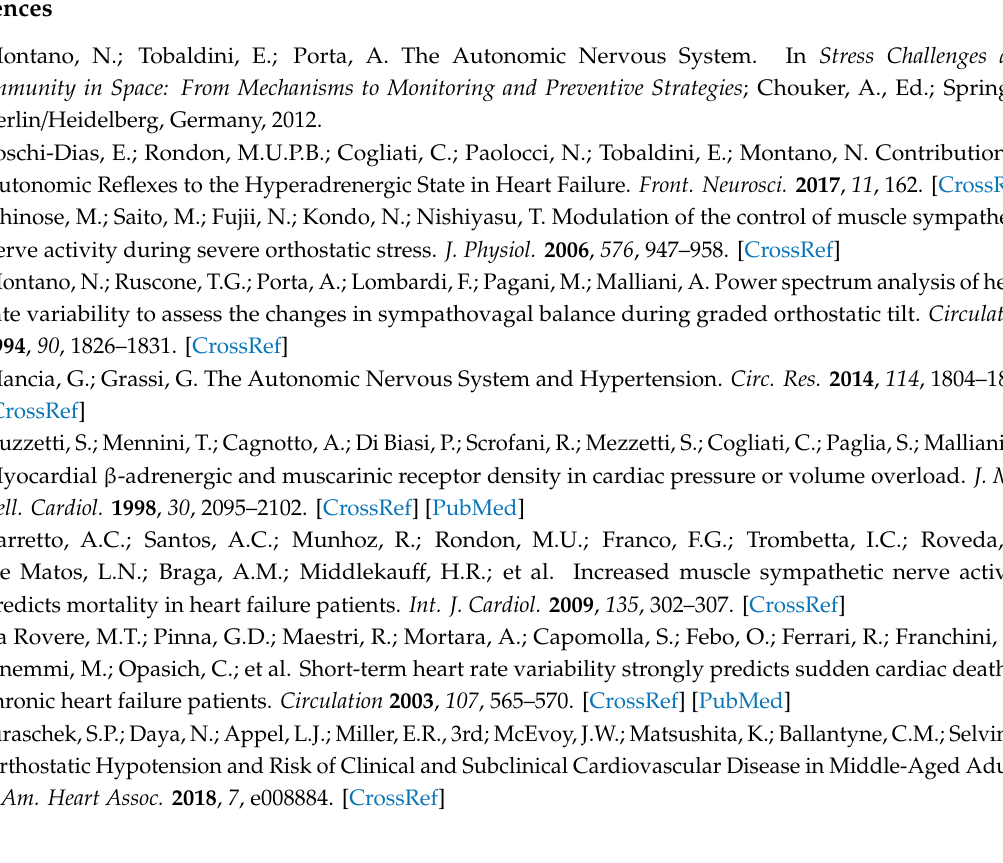
Table S1: Baseline measures of spectral parameters calculated by linear method using autoregressive model, Table S2. Baseline measures of dynamics patterns calculated by nonlinear method using symbolic analysis, Table S3. Baseline measures of transfer function calculated by bivariate autoregressive